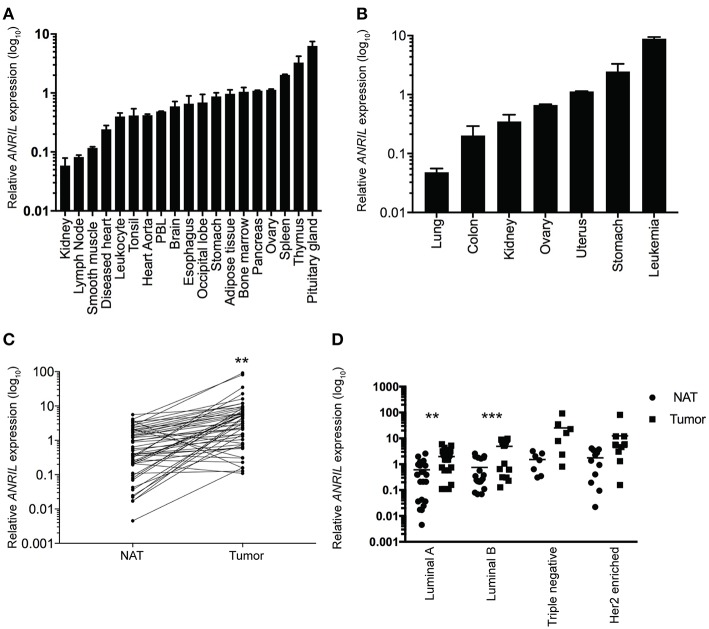
Relative ANRIL expression levels in various normal and cancer tissues including primary breast cancer. (A) RT-qPCR results from normal commercially available tissues showed a range of ANRIL expression levels suggesting ANRIL could be expressed as part of the tumor micro environment. (B) RT-qPCR results from cancerous commercially available tissues showed a range of ANRIL expression levels. Data represented as mean ± SEM for four replicates of each sample. (C) Line plot showing higher ANRIL levels in breast cancer tissue compared to the matched normal tissue adjacent to the tumor (NAT) from 60 breast cancer patients measured from RT-qPCR assays. ANRIL in tumors was significantly higher than NAT (**P < 0.01). (D) Profile of ANRIL expression amongst different tumor subtypes showed in Luminal A and Luminal B tumors ANRIL was increased in tumors compared to NAT (***P < 0.001). Data represented as mean ± SD for three replicates of each sample. All RT-qPCR normalized to GAPDH and HPRT.